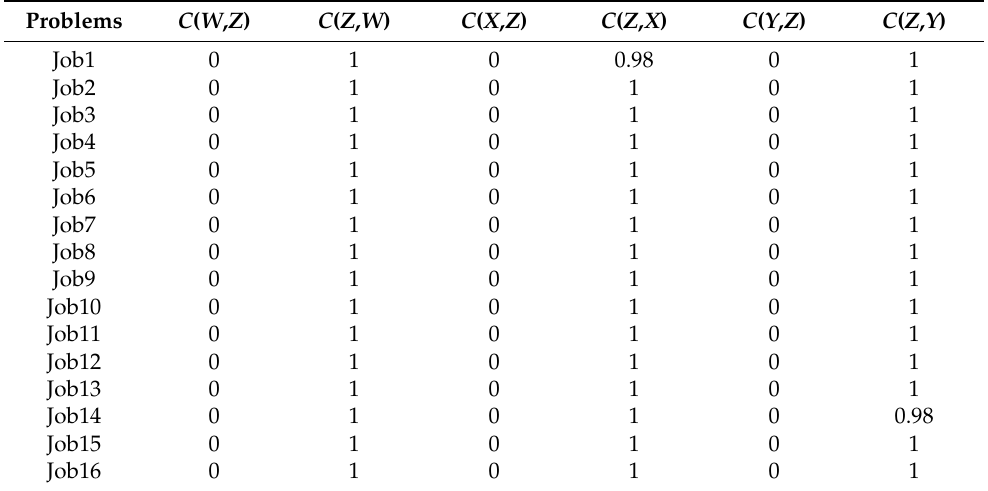
Table 8. C-metric of the solutions obtained by MOEA/D-MR, NSGA-II, SPEA2, and IMOEA/DTL. Problems